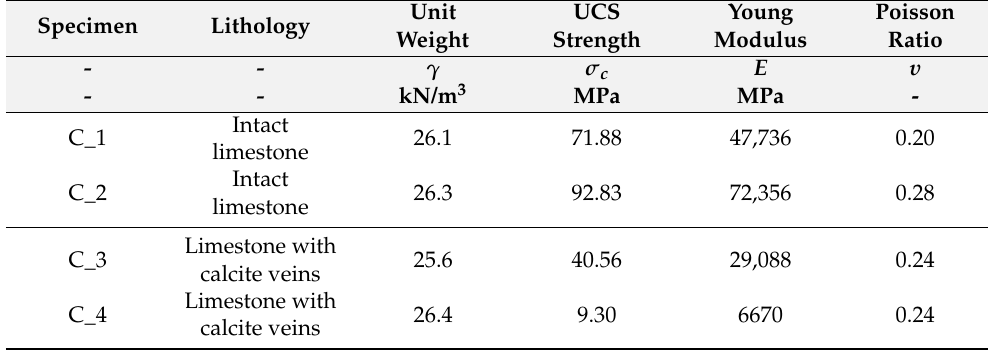
Table 1. Synthesis of physical and mechanical parameters derived from the laboratory tests.